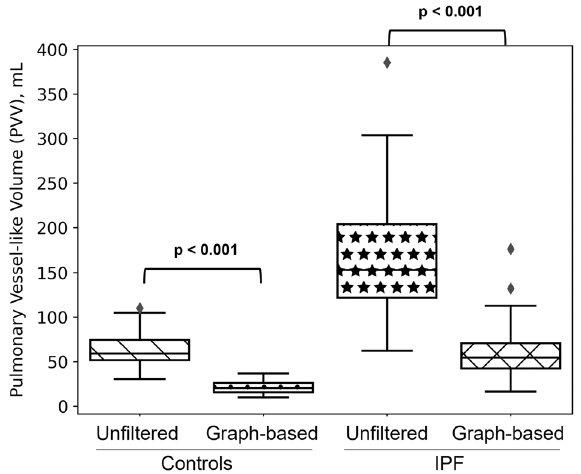
Figure 1. The impact of filtering segmentation artefacts on the estimation of pulmonary vessel-like volume (PVV) for IPF (baseline and follow-up data pooled) and controls. The four bar charts show PVV estimates for unfiltered and graph-based methods in controls and IPF. Graph-based PVV was lower in both IPF and controls. Statistically significant differences in volumes between the two cohorts were seen for both methods.